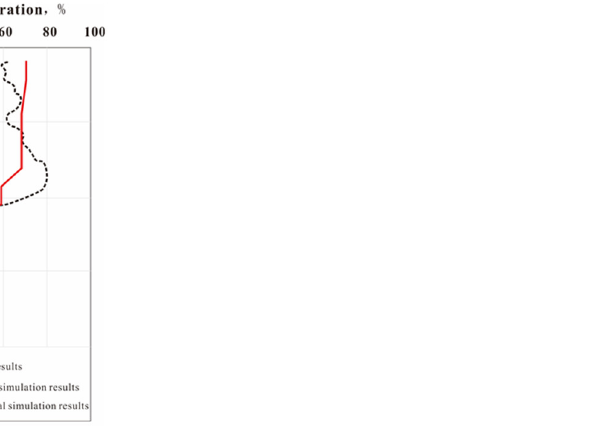
Figure 13. The comparison between the actual logging interpretation oil saturation curve and the model oil saturation curve of a passing well.